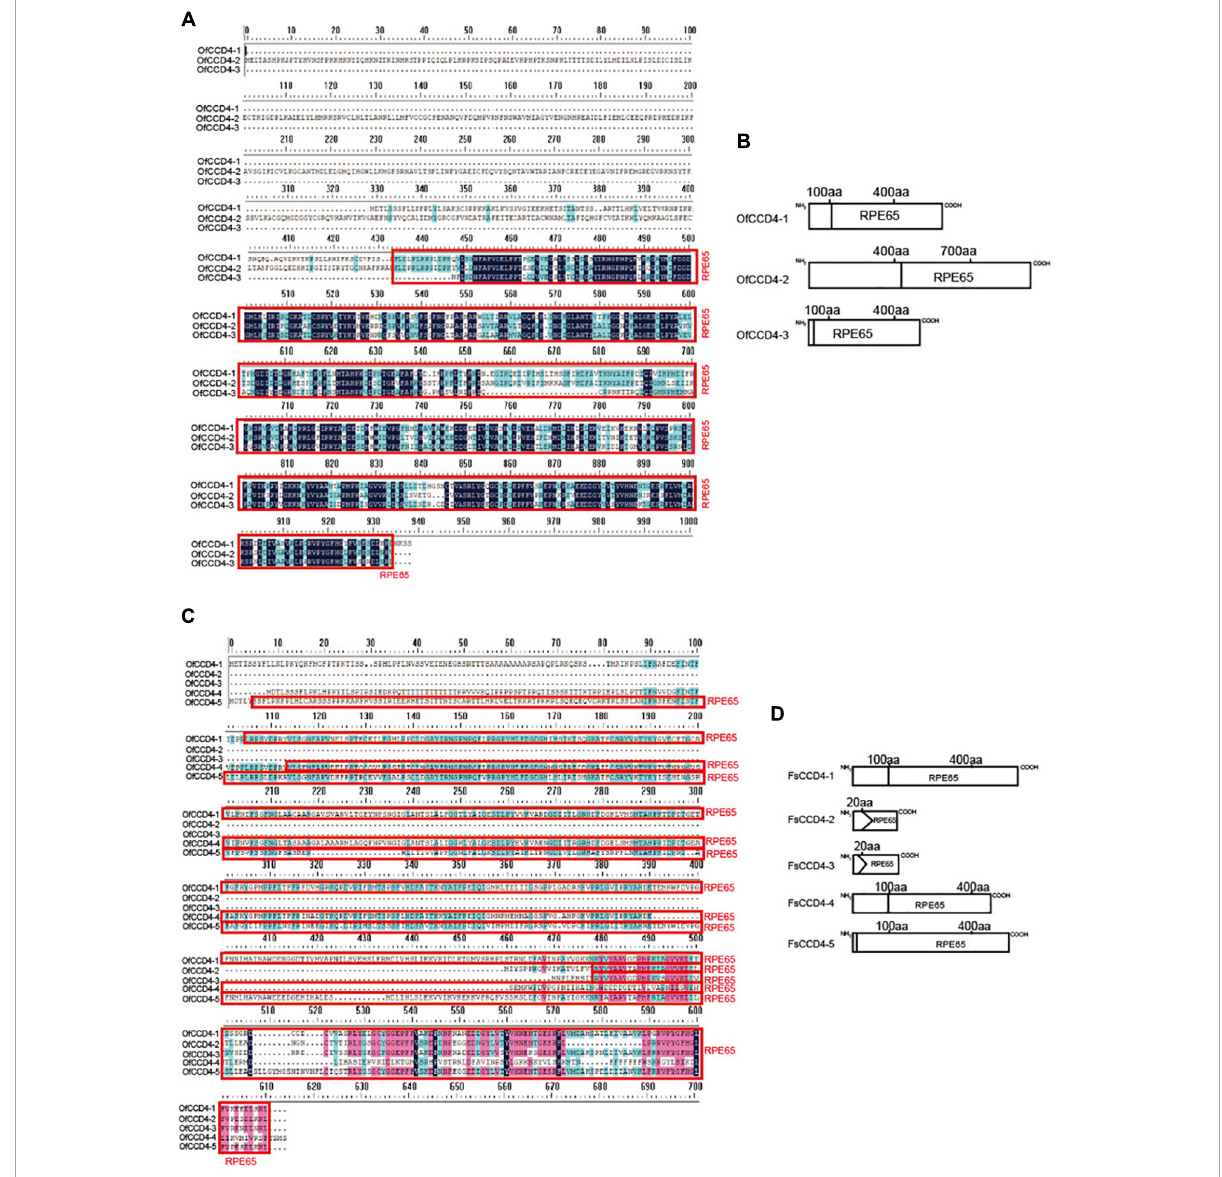
FIGURE5 Amino acid sequence and conserved domain of CCD4 genes of Forsythia suspensa and Osmanthus fragrans . (A) Amino acid sequence of CCD4 genes in Osmanthus fragrans ; (B) conserved domain of CCD4 genes in Osmanthus fragrans ; (C) amino acid sequence of CCD4 genes in Forsythia suspensa ; (D) conserved domain of CCD4 genes in Forsythia